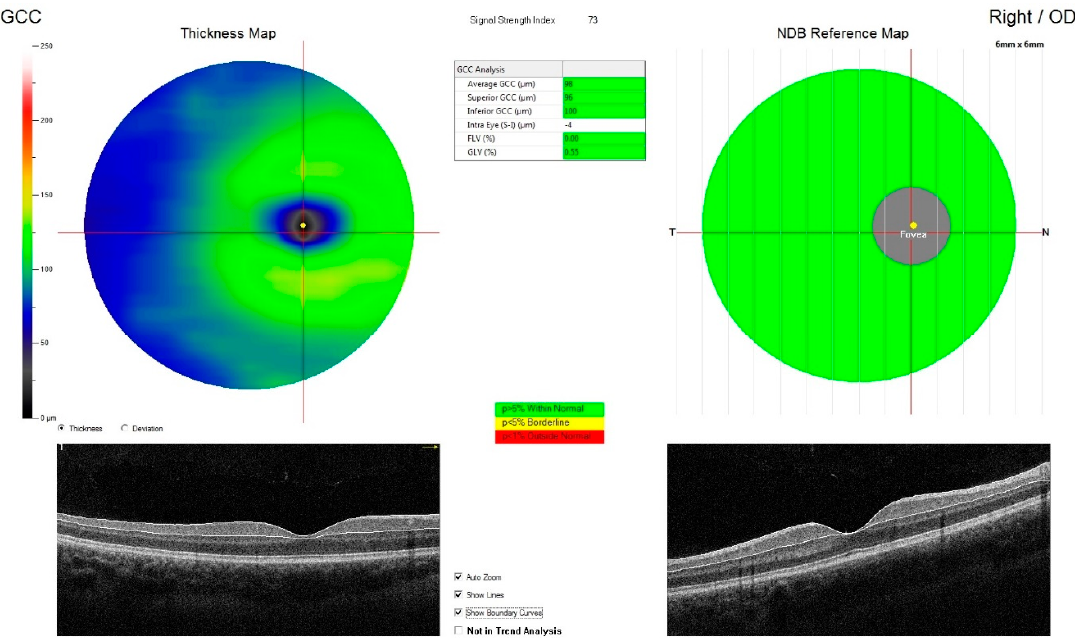
Figure 2. Measurement of retinal ganglion cell complex thickness in individual sectors of the eye such as the superior sector GCC thickness (supGCC), the inferior sector GCC thickness (infGCC) and the average thickness of both sectors (avgGCC).